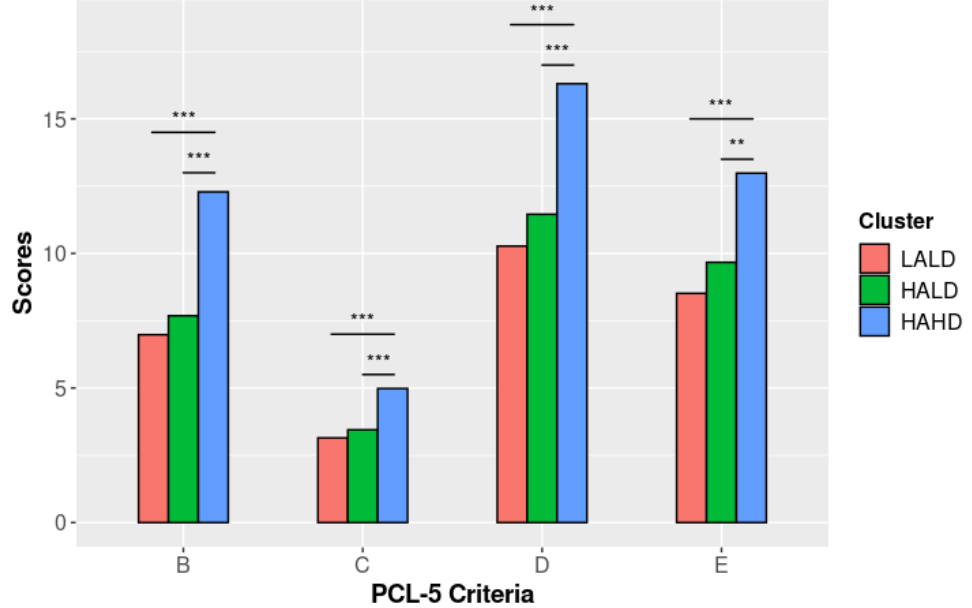
Figure 3. PCL-5 scores by cluster (adjusted models). Note. LALD: “Low Alcohol Low Dissocia- tion” subgroup; HALD: “High Alcohol Low Dissociation” subgroup; HAHD: “High Alcohol High Dissociation” subgroup; **: p < 0.01; ***: p <